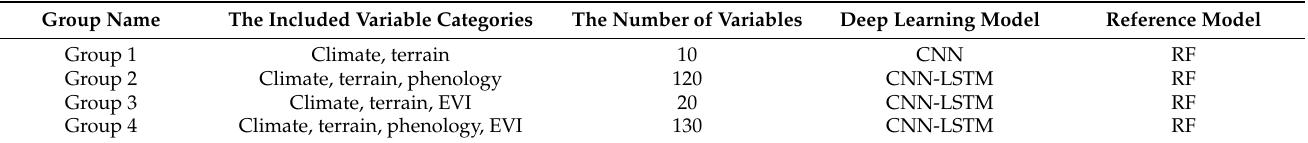
Table 4. The groups of environmental variables, the numbers of environmental variables, and the models applied for soil organic carbon